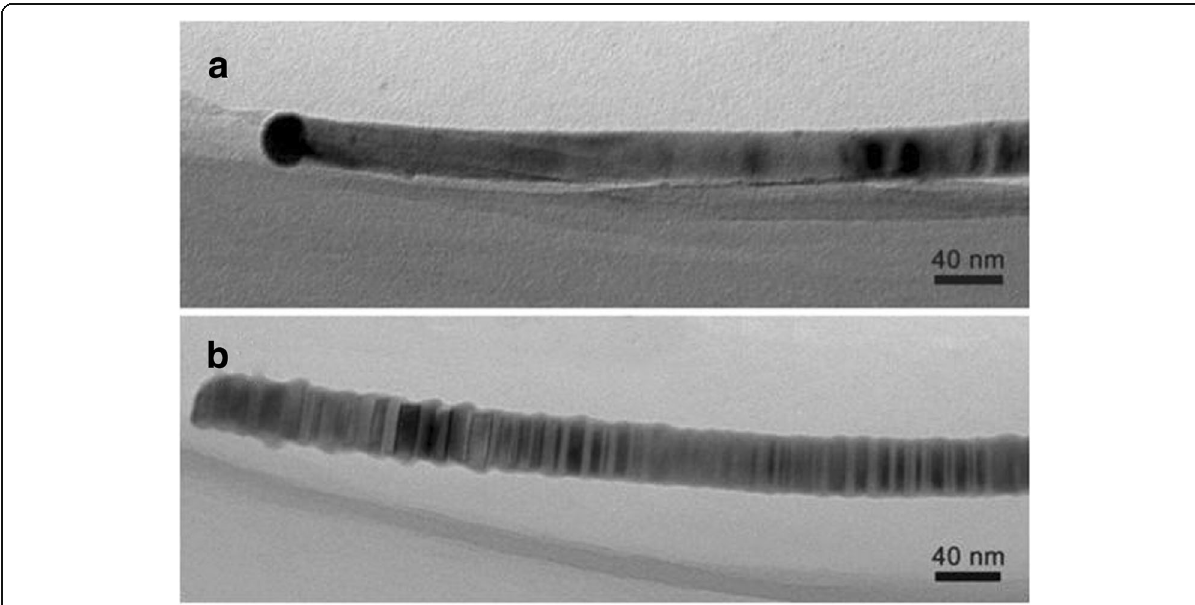
Fig. 3 TEM bright-field images of InGaAs NW with two different morphologies, a smooth surface and b zigzag